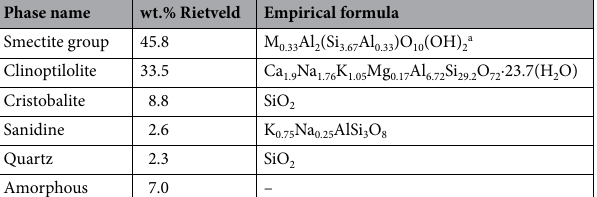
Table 1. Mineral composition of the natural zeolite used in the experiments (on a dry basis). a M = Ca 2+